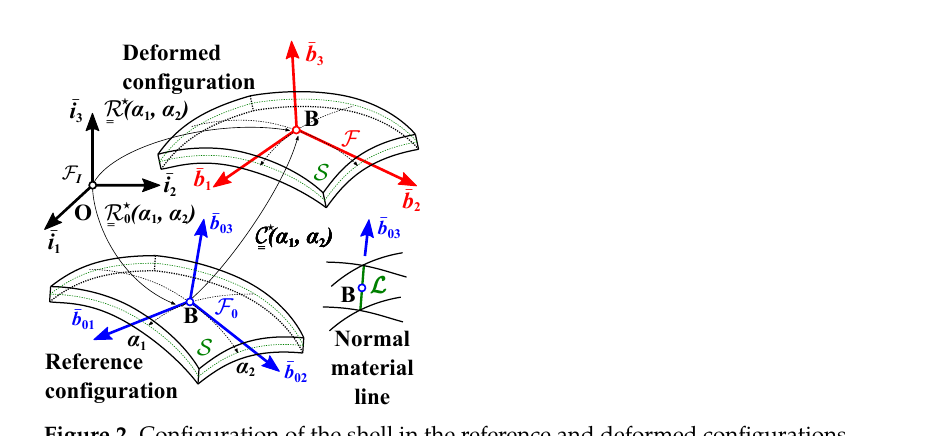
Figure 2. Configuration of the shell in the reference and deformed